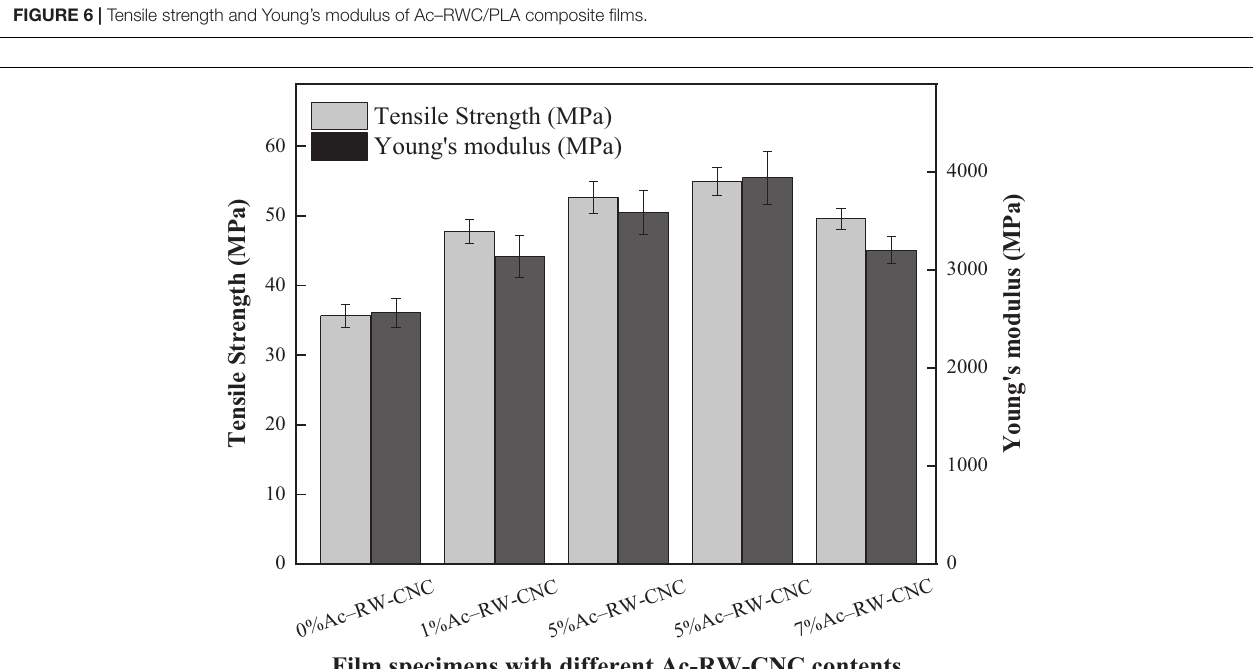
FIGURE 6 | Tensile strength and Young’s modulus of Ac–RWC/PLA composite films.